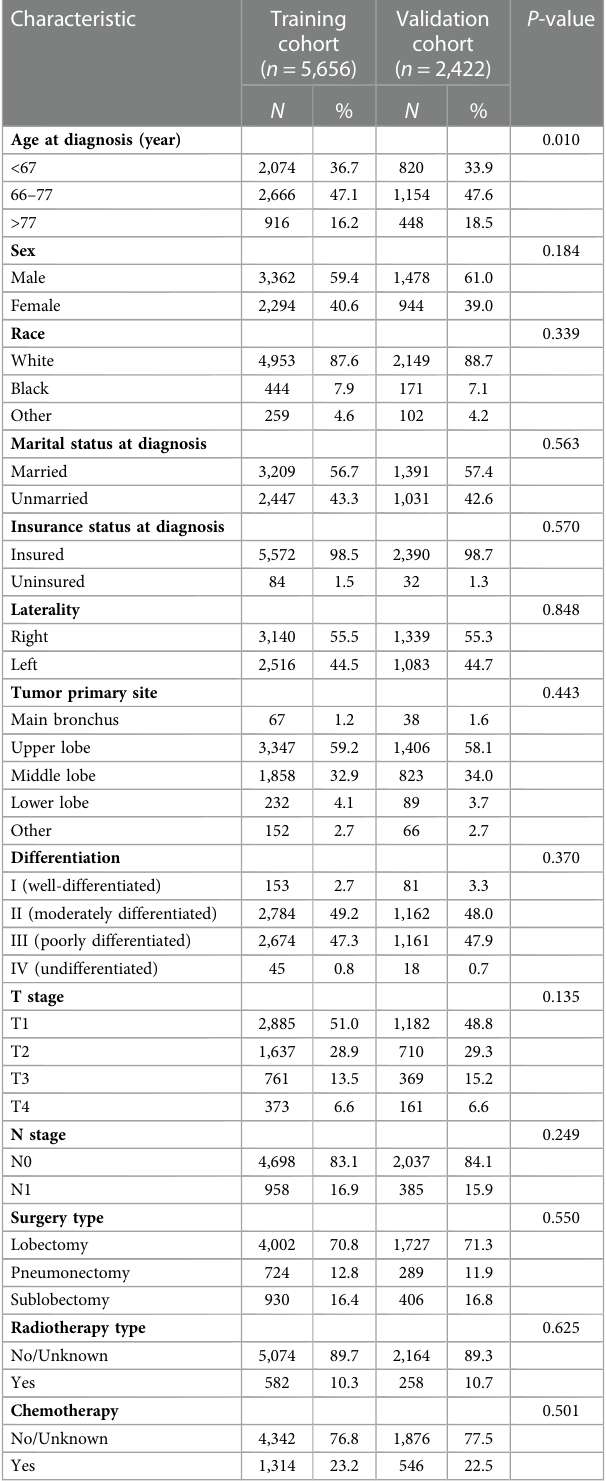
TABLE 1 Characteristics of LSCC in training and validation